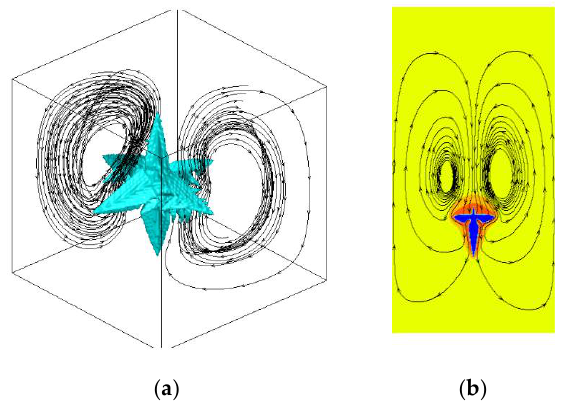
Figure 4. The streamline distribution of 3D and 2D: ( a ) flow field as the 3D dendrite falls, and ( b ) flow field as the 2D dendrite falls.